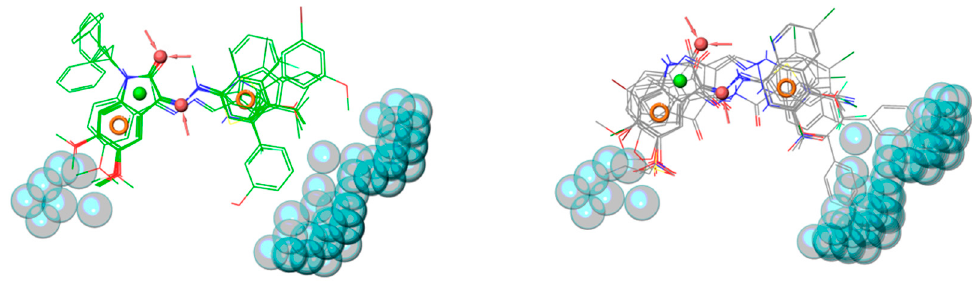
Figure 3. Overlay of actives (in green) and inactives (in gray) shown on the left-hand and right-hand side, respectively.